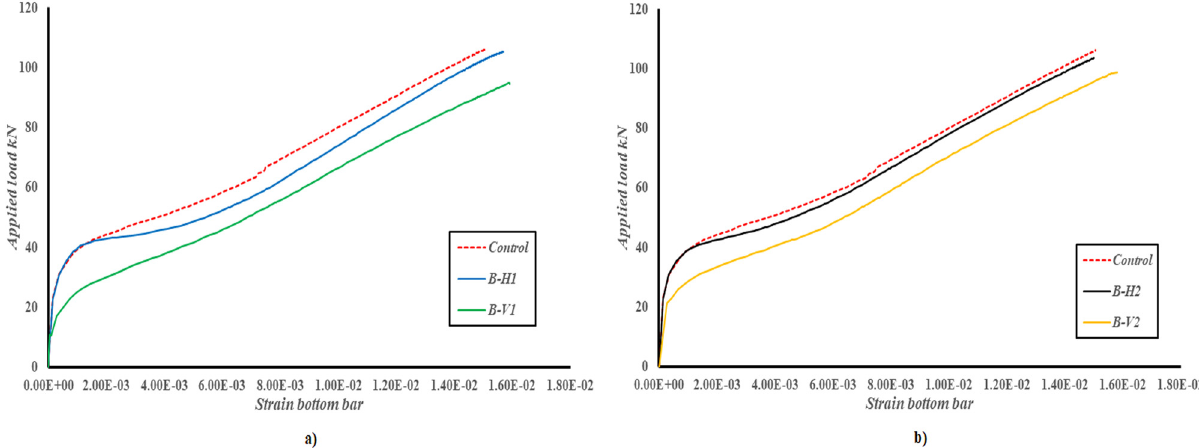
Figure 6: Load – main GFRP bars strain for the analyzed beams ( e ff ect of opening orientation ) . ( a ) Beams with one opening and ( b ) beams with two